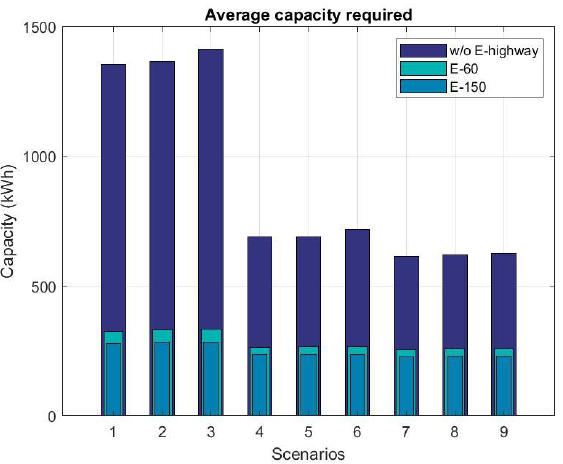
Figure 8. Minimum required capacity — average of all trucks in each scenario (own